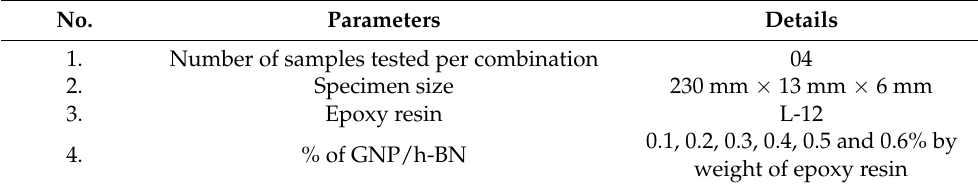
Table 6. Sample Characteristics (Four-Point